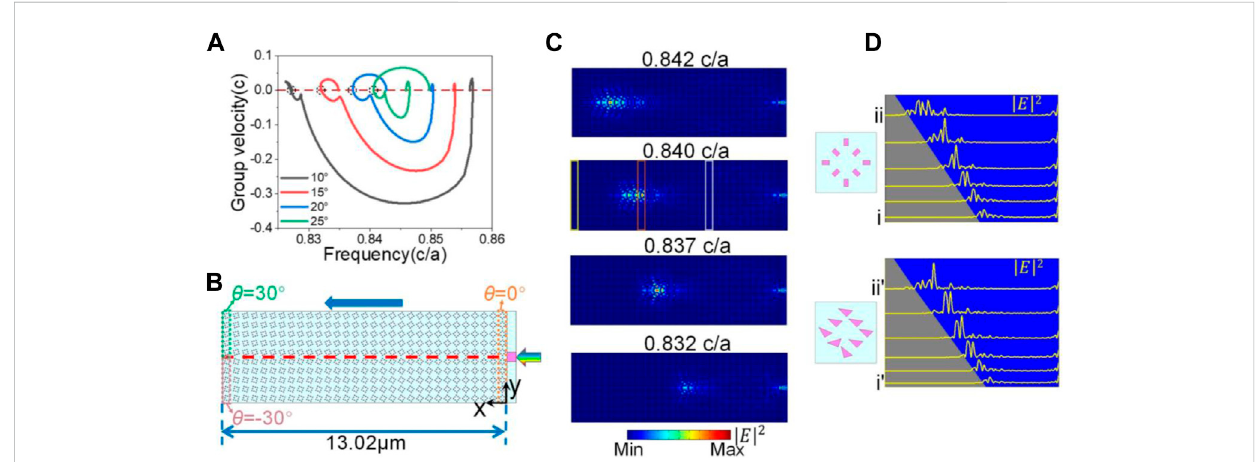
FIGURE 2 (A) Group velocity of upper edge states of supercells with different rotated angles. The red dashed line is where the group velocity is zero. Black dashed circles indicate the zero-group velocity positions. (B) Con fi guration used to implement the topological rainbow. The rotated angle of the supercell increases the degree one by one from the right to the left. Light is incident from the right through a waveguide. (C) | E | 2 fi eld distribution of differentfrequencies. (D) Unit cells with other shaped pillars are used to realize a topological rainbow. The corresponding | E | 2 distribution along the red dashed line of (B) is shown on the left side of the cells. The yellow lines at different positions represent different frequencies. i represents a frequency of 0.801 c/a , and ii represents 0.811 c/a . i ’ is 0.712 c/a , and ii ’ is 0.722 c/a . The blue and gray parts show the regions of existence and non-existence of the edge